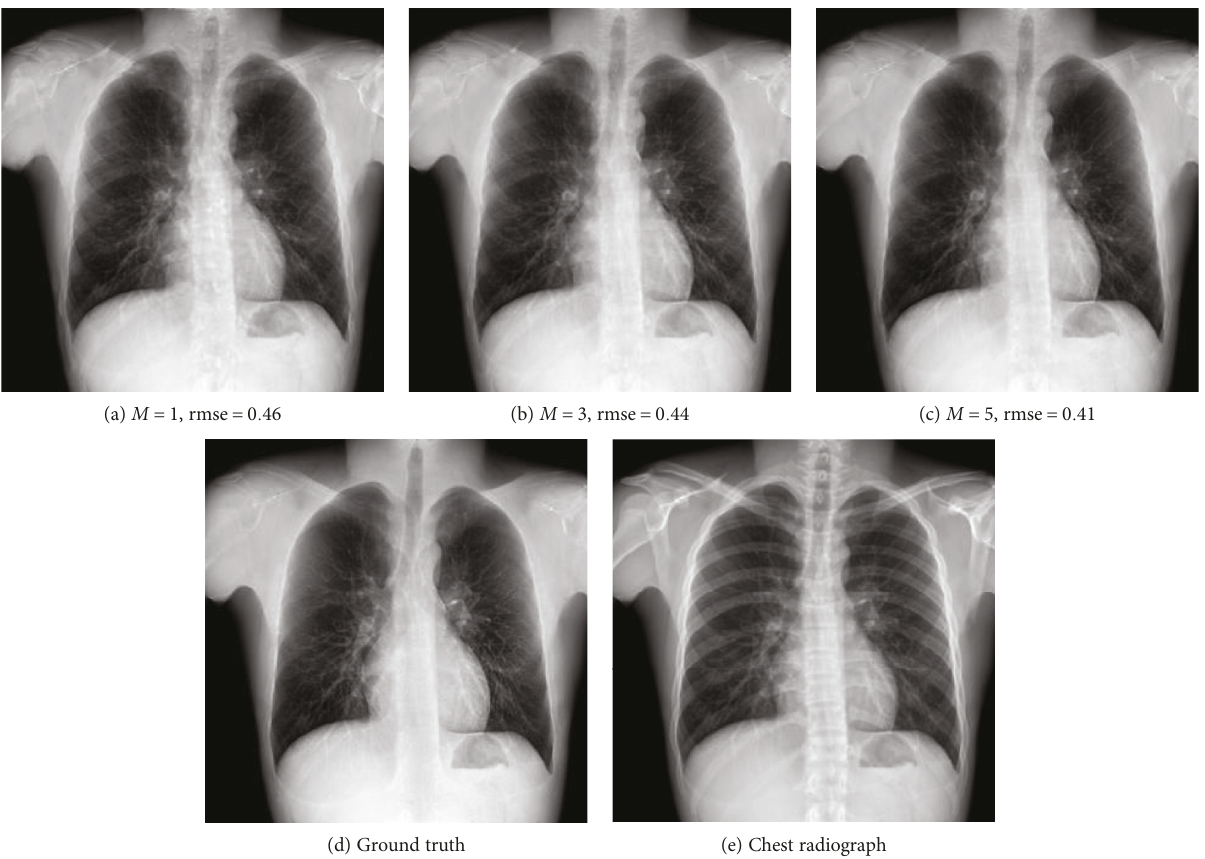
Figure 9: The reconstructed soft tissue images using the di ff erent numbers of exemplars. From left to right, the numbers of used exemplars ( M ) are 1, 3, and 5, respectively. rmse is the root mean squared error of the reconstructed soft tissue image. (a – c) are the reconstructed soft tissue images. (d) corresponds to the ground truth. The corresponding standard chest radiograph is